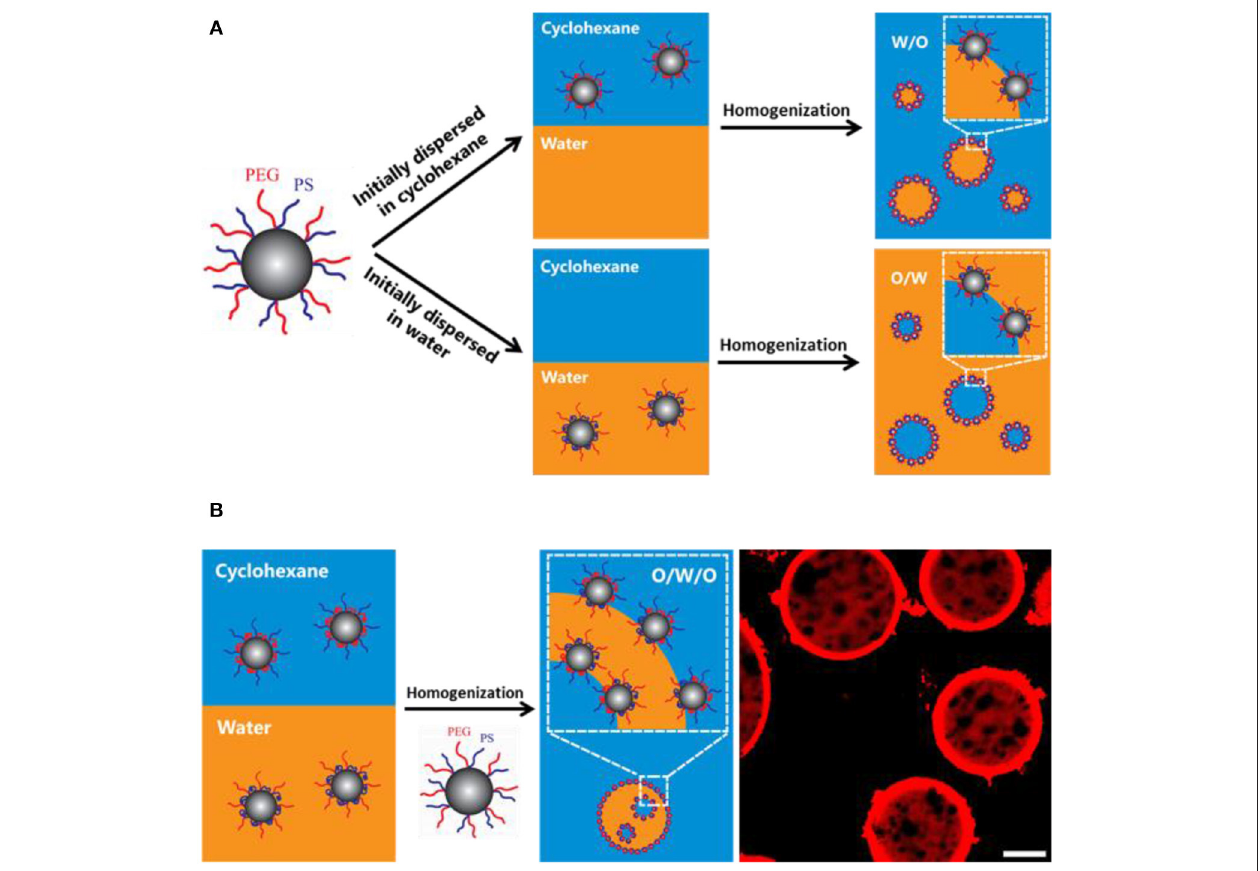
FIGURE 10 | Schematic representation of the initial location of silica nanoparticles on the emulsion type (A) and emulsification of multiple emulsions (B) (Liu et al., 2016 ). Reprinted with permission from Liu et al. (2016). Copyright 2016 American Chemical Society.